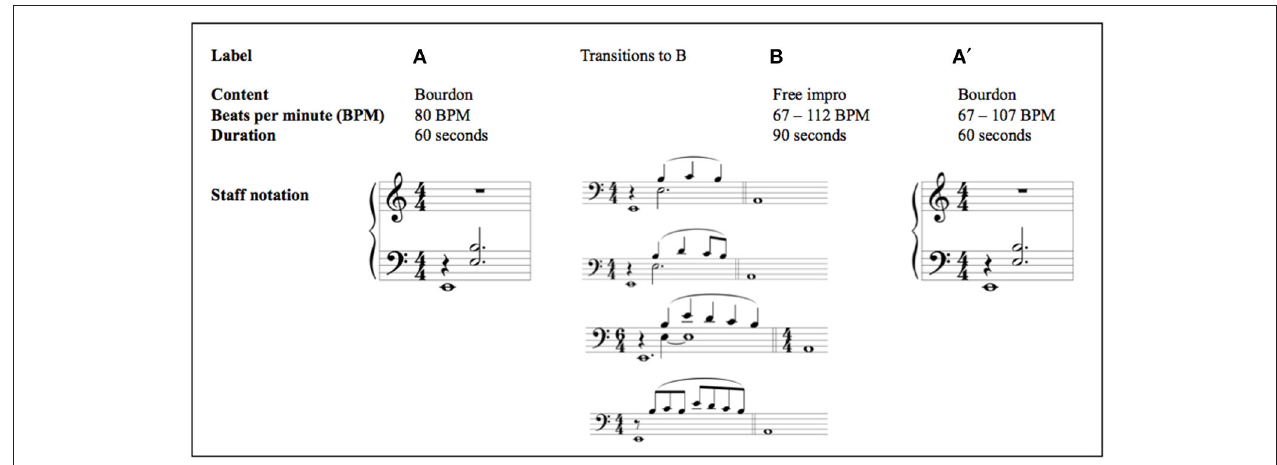
FIGURE 1 | This figure represents the ABA ′ structure of the accompaniment design, with characteristics in content, beats per minute (BPM), and duration. To make the transition to part B, the improviser added a short melodic phrase above the bourdon, which initiates the new character and mode. The staff notation excerpts contain the bourdon accompaniment figure, as well as the most frequently played transitions from A to B in this study.